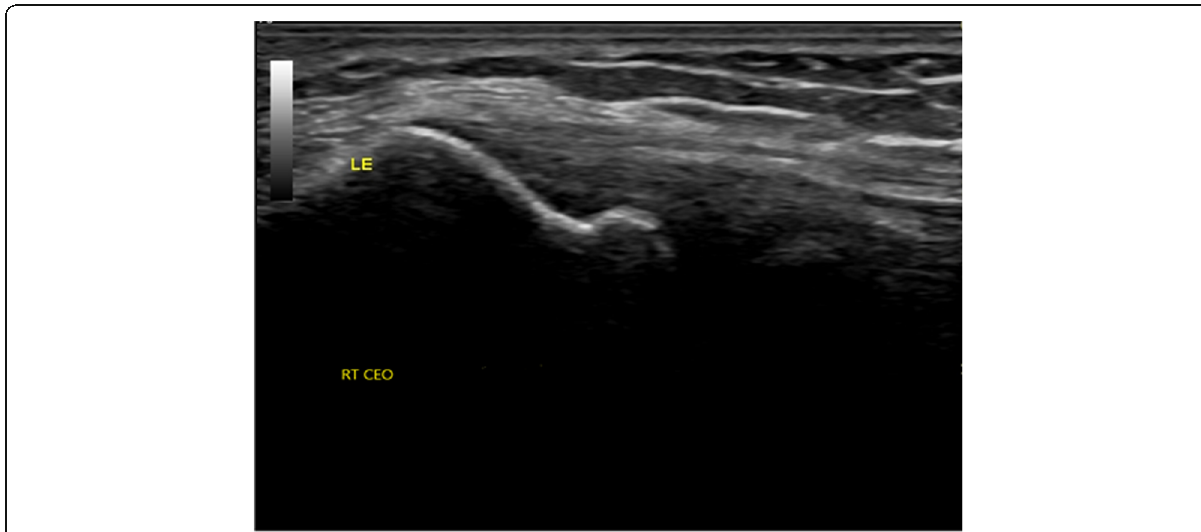
Fig. 3 US picture showing improvement of hypoechogenicity and fibrillar pattern of Rt. CEO tendon in the same patient after PNI treatment. LE, lateral epicondyle; RT, right common extensor